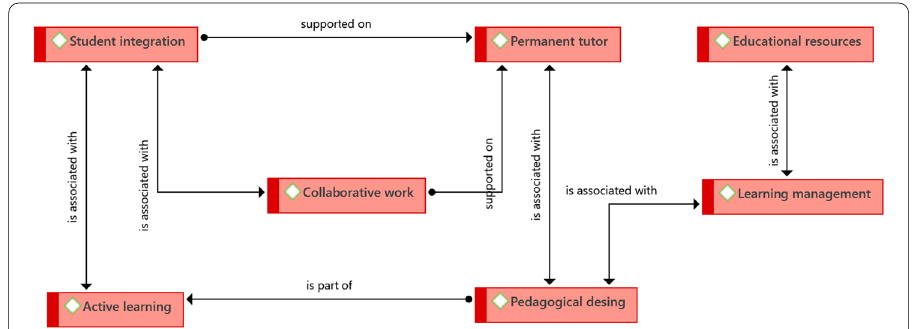
Fig. 3 Structure of driving ideas that guide the educational component. Source: Diógenes